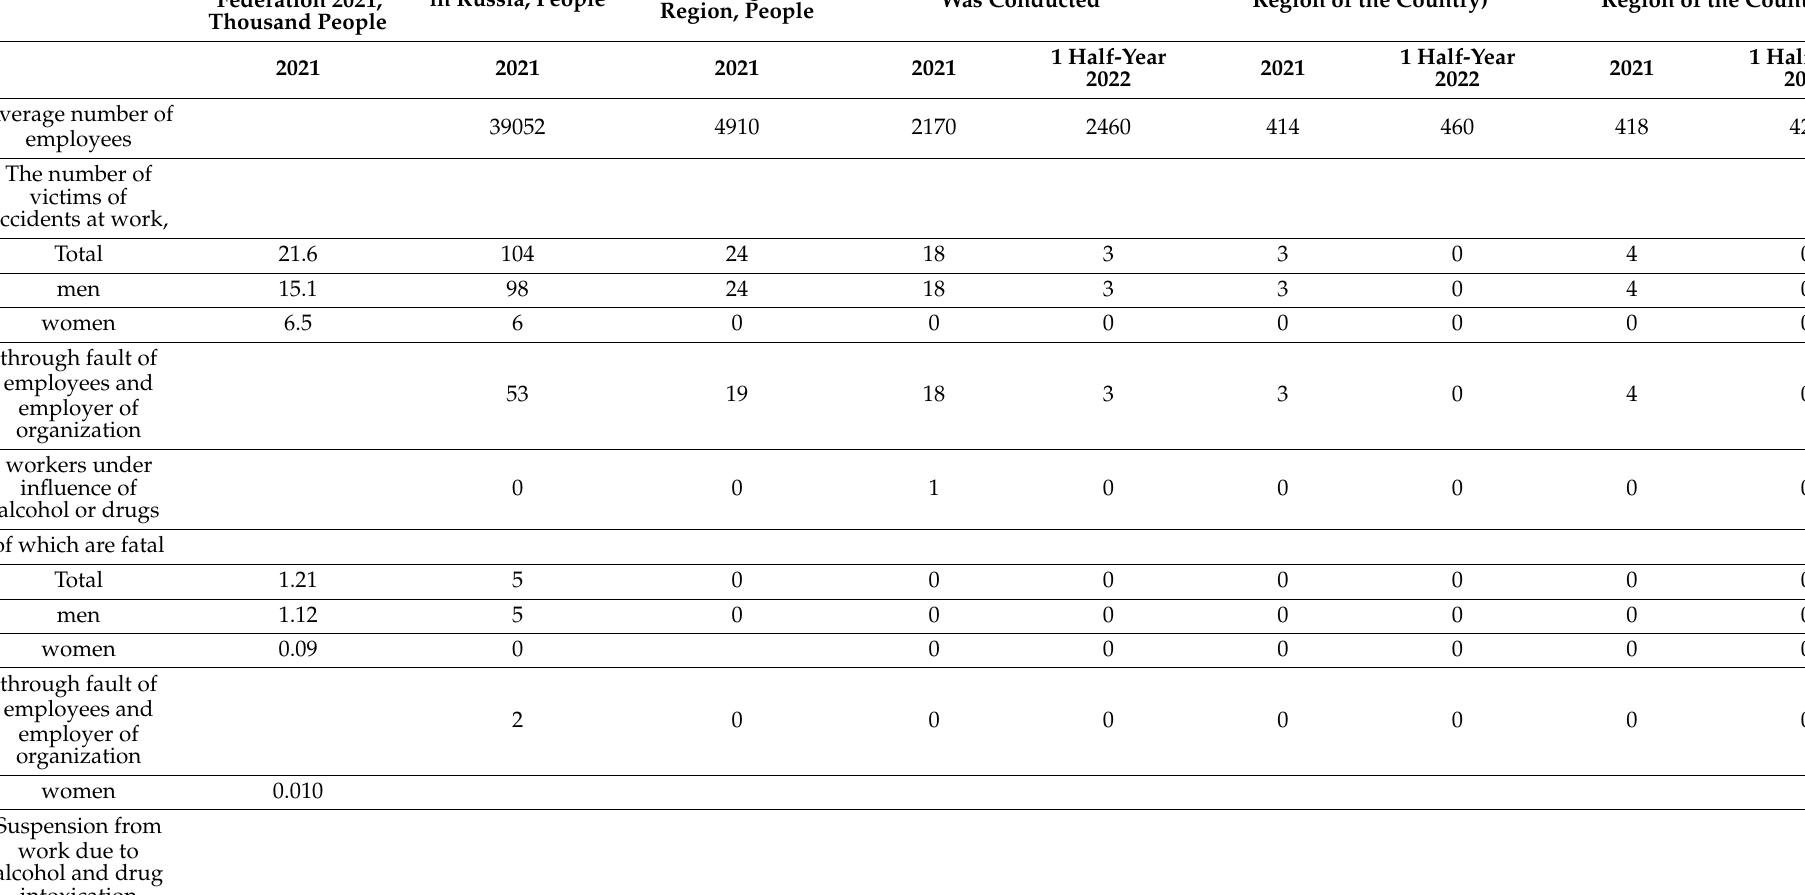
Table A2. The number of victims of industrial accidents in the forest harvesting industry in the Russian Federation and the Arkhangelsk region. All Enterprises of the